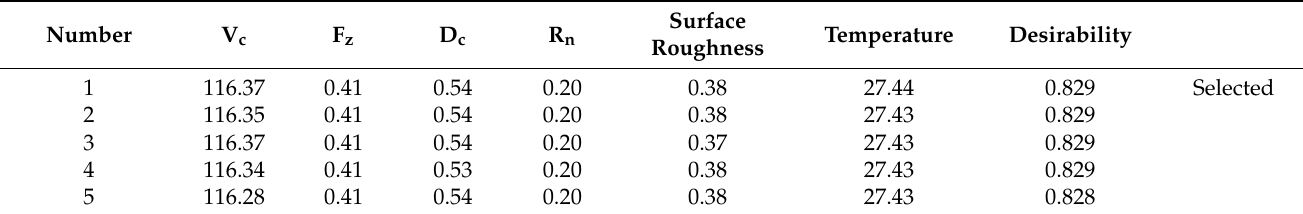
Table 7. Best global solution for an optimization.